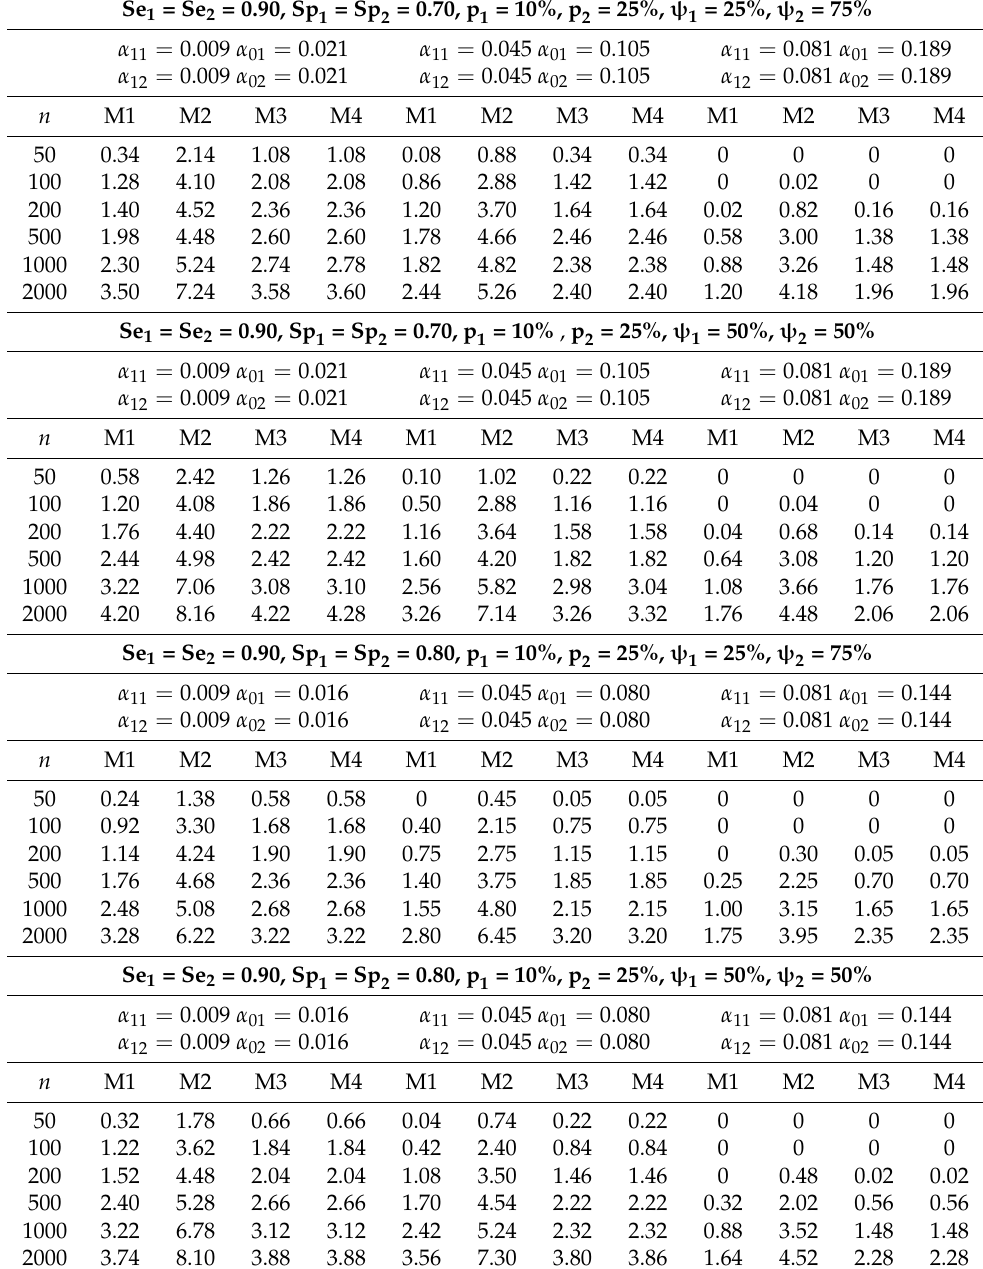
Table 2. Type I errors (in %) of different methods to simultaneously compare the sensitivities = 0.90 ) and specificities ( Sp = { 0.70,0.80 } ) of two BDTs in the presence of a binary ( Se h h